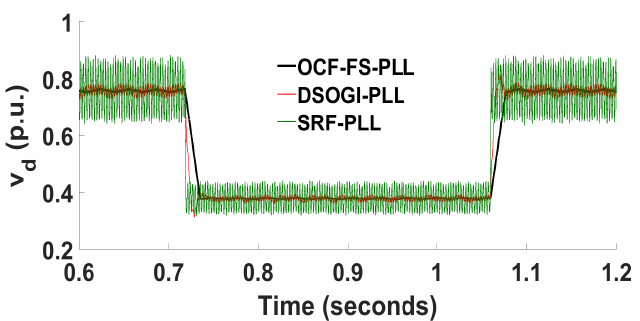
Figure 12. The v g , d positive sequence component during voltage sag under the presence of the 5th harmonic.